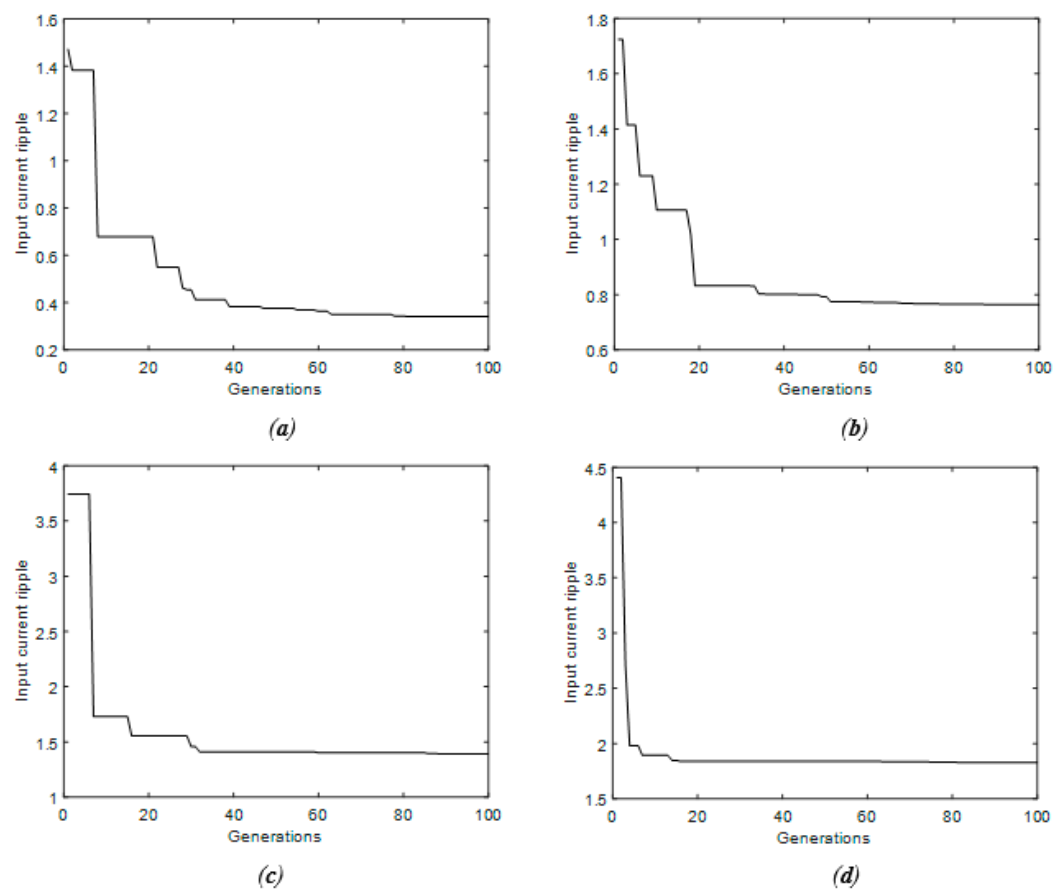
Figure 8. Convergence graph of the DE algorithm for ( a ) G = 3.5 , ( b ) G = 4 , ( c ) G = 5 , and ( d ) G = 6.